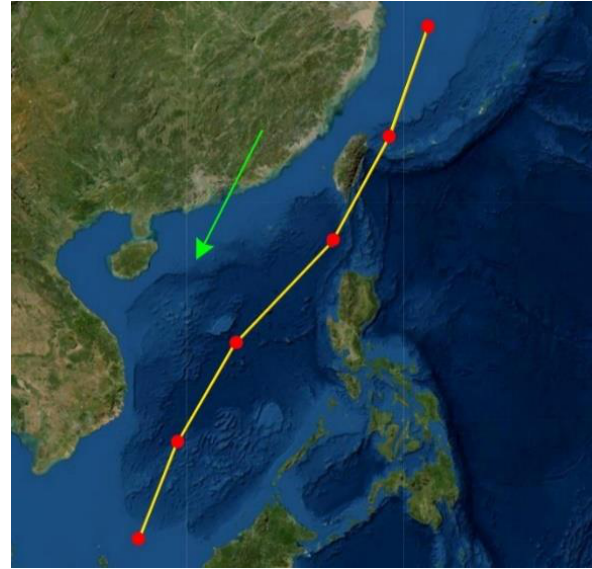
Figure 2. A section of route with five legs and six